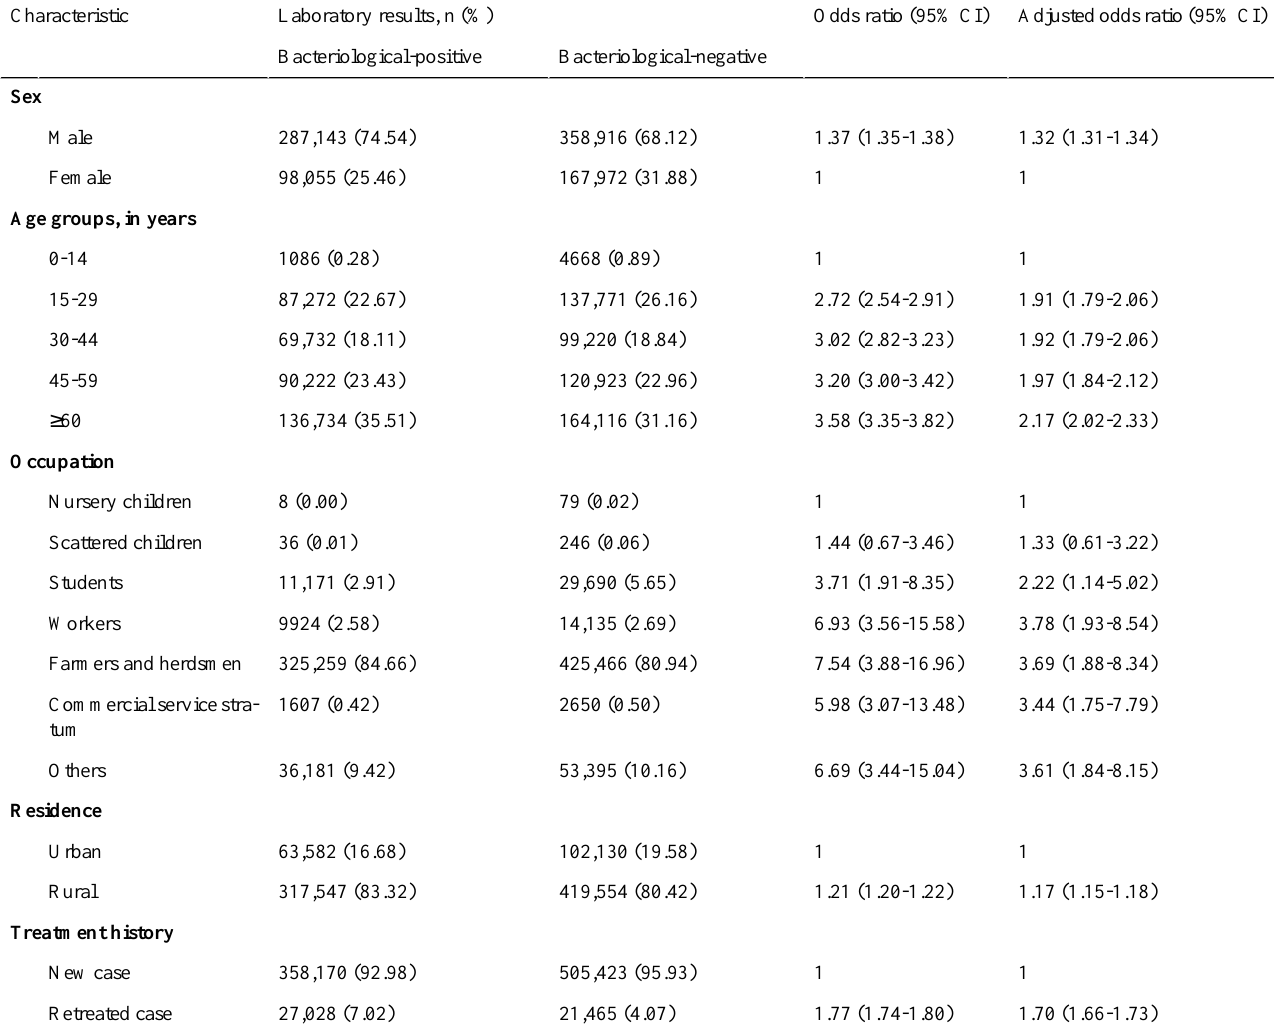
Table 3. Risk factors for bacteriological-positive infection cases in Henan province,